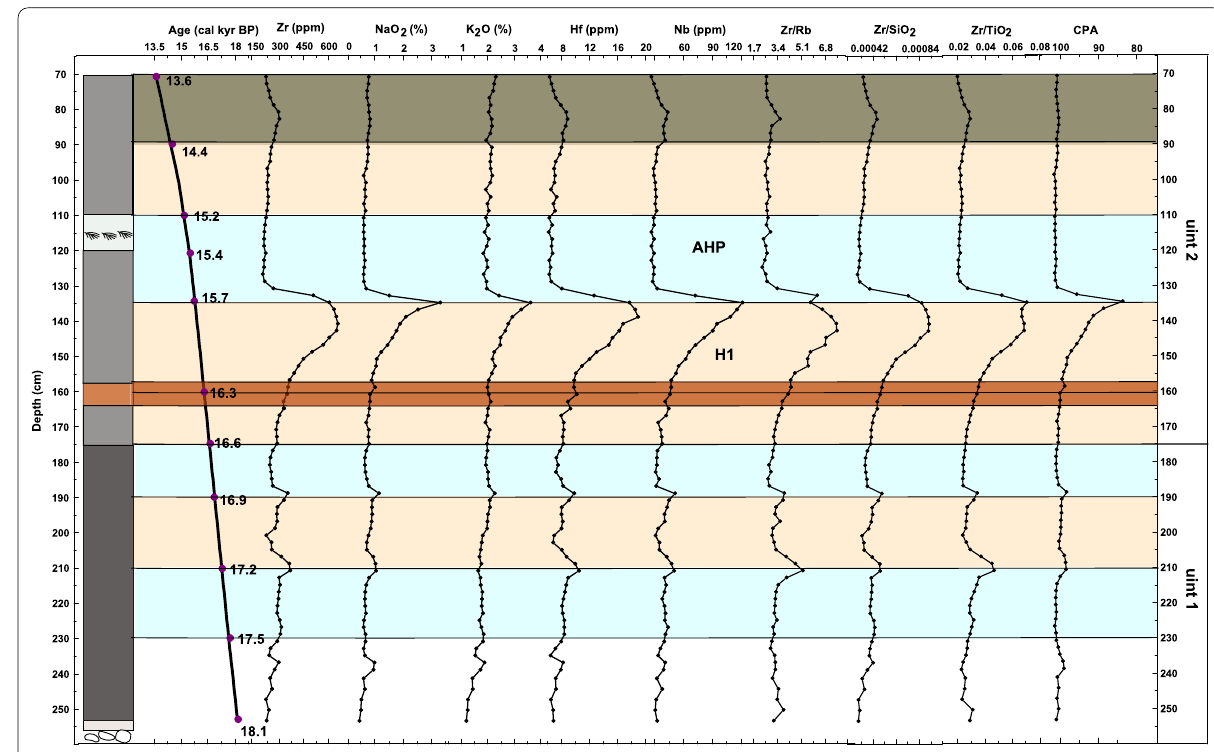
Fig. 5 XRF results of B4 sediments. Depth profiles of Zirconium (Zr), Sodium oxide (Na 2 O), Potassium oxide (K 2 O), Hafnium (Hf), Niobium (Nb), Zirconium/Rubidium (Zi/Rb), Zirconium/Silica oxide (Zr/SiO 2 ), Zirconium/Titanium oxide (Zr/TiO 2 ) and of the chemical proxy of alteration (CPA Al 2 O 3 /(Al 2 O 3 Na 2 O), inversed scale. The light orange color shows dryer events while orange color indicate desiccation layers developed = + during Heinrich Event 1(H1) and the hiatus. Blue color indicates the African Humid Period (AHP) and other humid episodes while dark green color indicates the event characterized as humid and arid according to pollen and geochemical results,